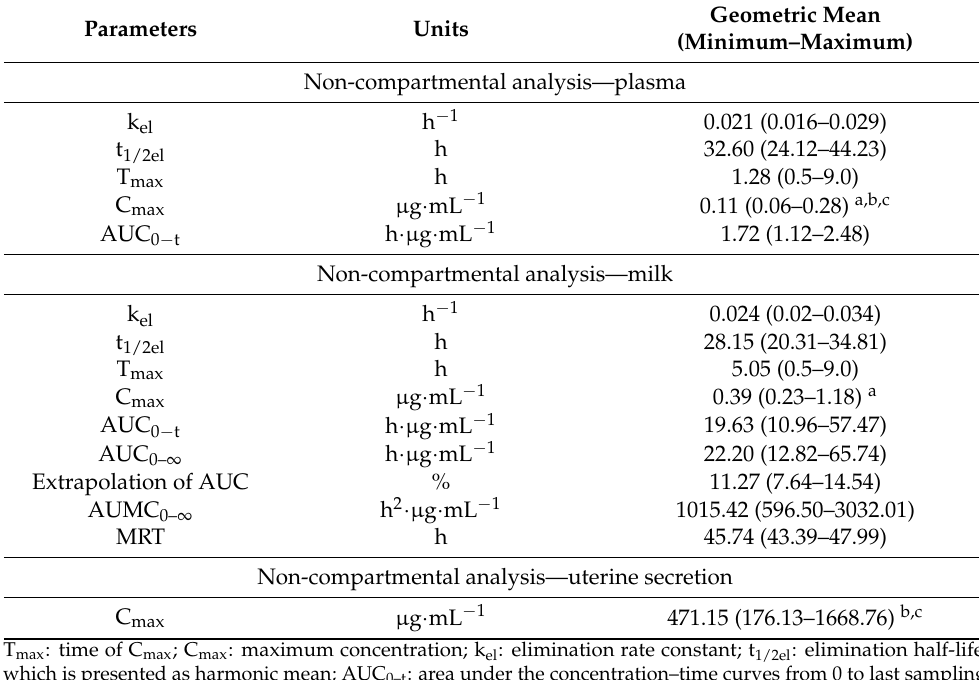
Table 2. Pharmacokinetic parameters of oxytetracycline after intrauterine administration in cows ( n = 6) at a dose rate of 8 mg/kg oxytetracycline as 10% solution for three consecutive days.